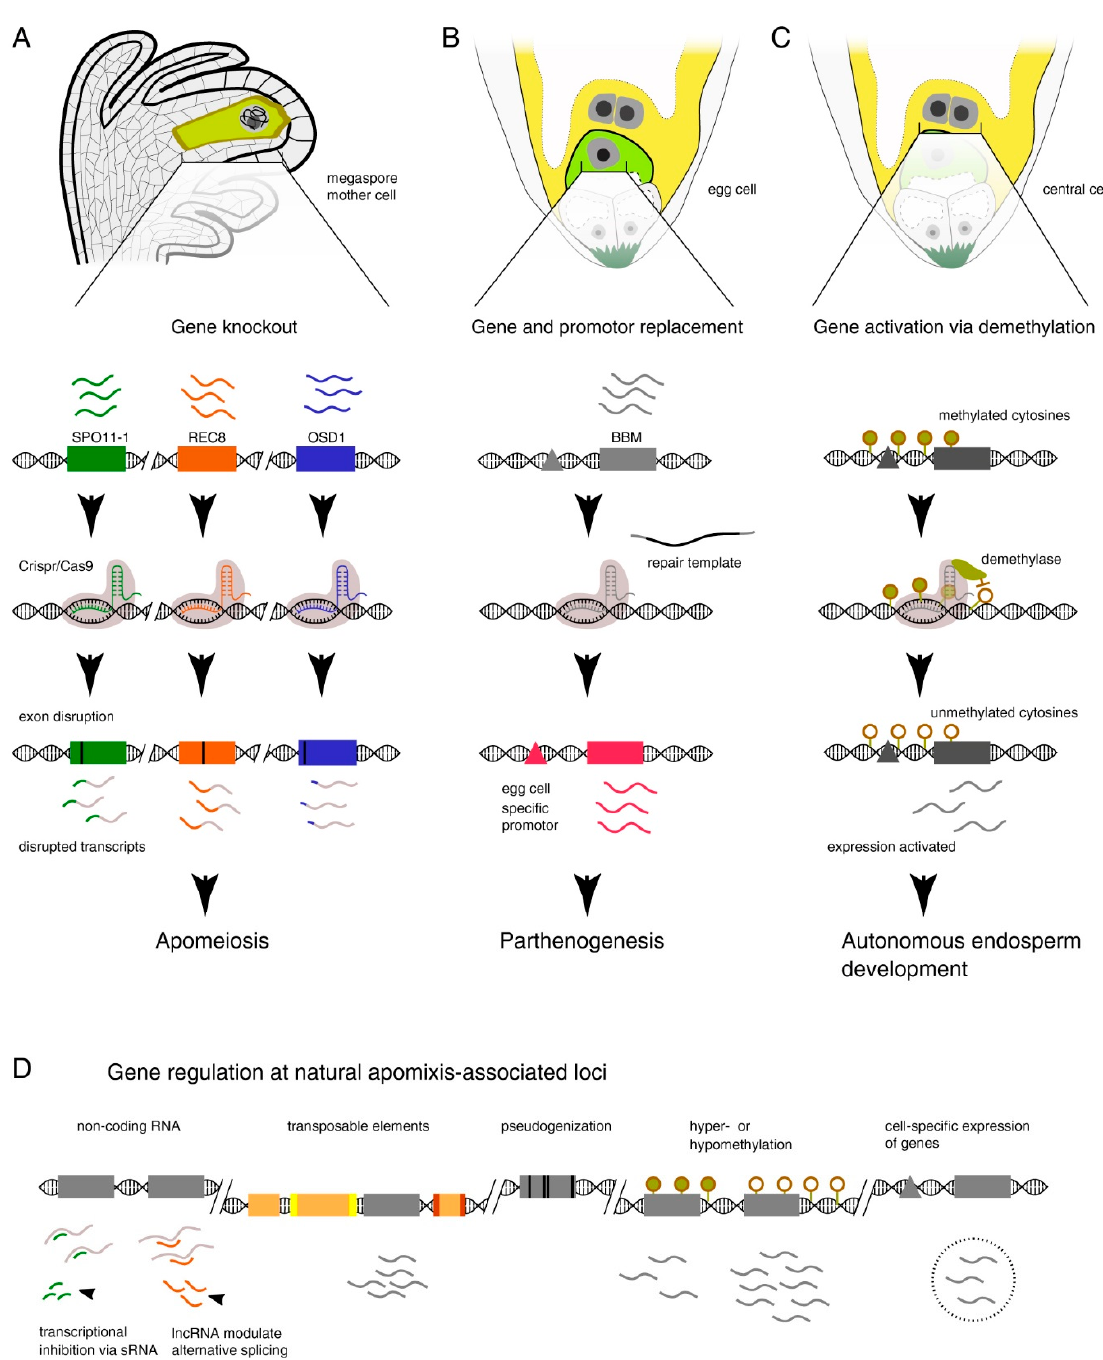
Figure 2. Illustration of gene editing approaches that could be used to target apomixis master genes or multiple genes affecting specific developmental steps and having a master-like effect (for simplicity, we display known gene names associated with reproductive modules and targeted in de novo apomixis strategies). ( A ) Gene knockout can be used to convert meiosis to mitosis, as has been shown using the Mitosis instead of Meiosis (MiMe) mutants. ( B ) Tissue-specific promotors and targeted gene replacement for a gene such as BBM could induce embryo development without fertilization. ( C ) Using Cas9 as a recruiting platform for demethylase would allow activation of repressed female genes, for instance to erase genomic imprinting and trigger autonomous endosperm development. ( D ) Features of observed genomic and regulatory variation at natural apomixis loci such as those known from Pennisetum/Cenchrus [82] and Paspalum [86–88]. Another hurdle might relate to the hemizygous condition of sequences linked to apomixis [68,69,89]. Sequences were considered hemizygous, because previous studies often did not detect an